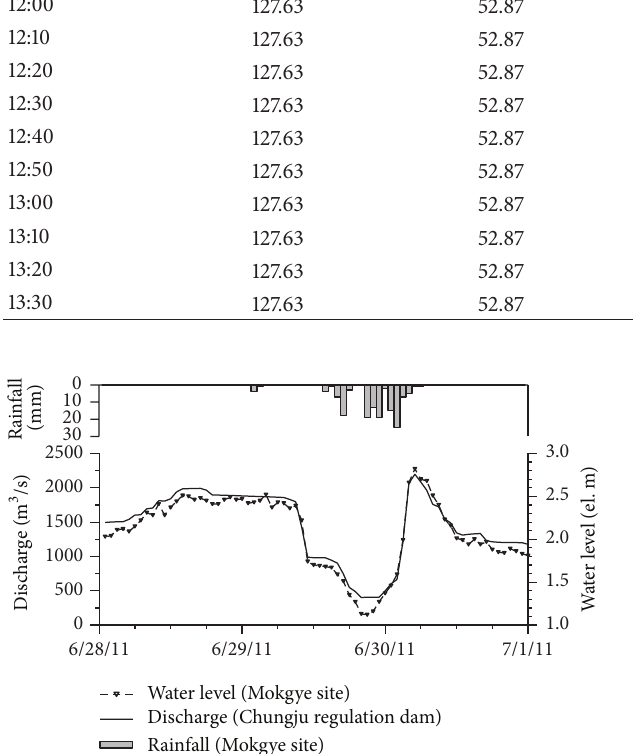
Figure 4: Discharge data from Chungju regulation dam and water levels at the Mokgye